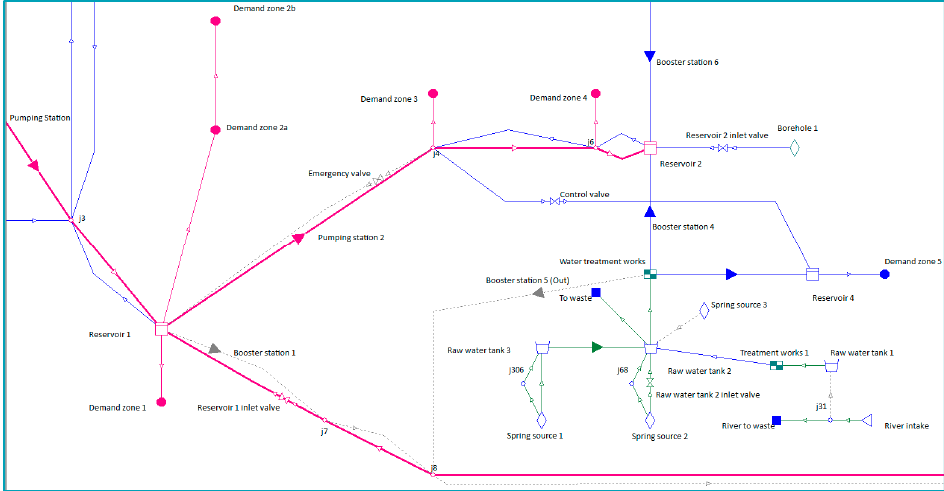
Figure 2. OptiMISER Phase 1 Area Schematic (part;